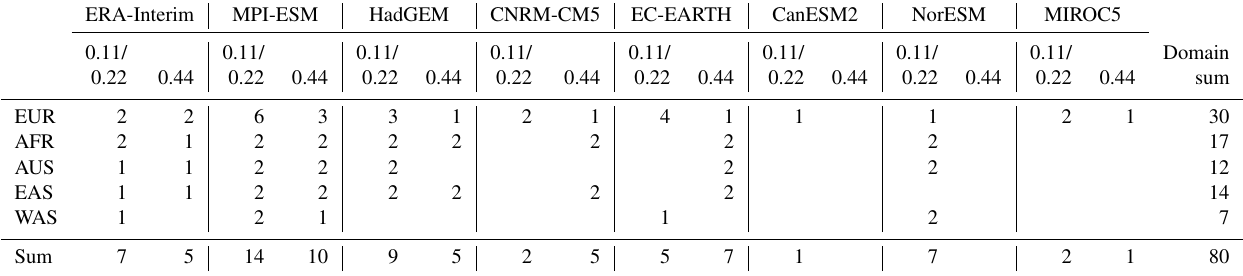
Table 1. Number of COSMO-CLM simulations available for the different domains (EUR: Europe, AFR: Africa, AUS: Australasia, EAS: East Asia, WAS: South Asia), driven by ERA-Interim (Dee et al., 2011), CanESM2 (Arora et al., 2011; Von Salzen et al., 2013), CNRM-CM5 (Voldoire et al., 2013), EC-EARTH (Hazeleger et al., 2012), HadGEM (HadGEM2-ES, Collins et al., 2011; The HadGEM2 Development Team, 2011; HadGEM-AO, Baek et al., 2013), MIROC5 (Watanabe et al., 2011), MPI-ESM-LR (Stevens et al., 2013), and NorESM1-M (Iversen et al., 2013). The respective ERA-Interim simulation is the evaluation run and is typically from 1979 to 2010. The GCM-driven simulations include a historical simulation (1950–2005) and one or more scenarios RCP2.6/4.5/8.5 (2006–2099). For each domain, up to two different horizontal grid spacings are used: 0.44 ◦ (50km) and 0.11 ◦ (12km, only for Europe) or 0.22 ◦ (25km, for all the other domains). From the GCM’s ensembles the first realization (r1) is used for all the GCMs, except for EC-EARTH (r12) and for MPI-ESM (three members: r1, r2, and r3). The HadGEM-ES GCM is used for all domains, except for East Asia, where HadGEM-AO is